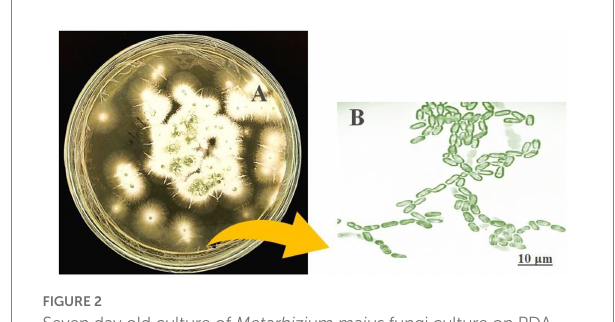
FIGURE 2 Seven day old culture of Metarhizium majus fungi culture on PDA media. (A) Metarhizium majus culture, (B) Fungal conidial morphological structures at 40× magnification under light microscope.